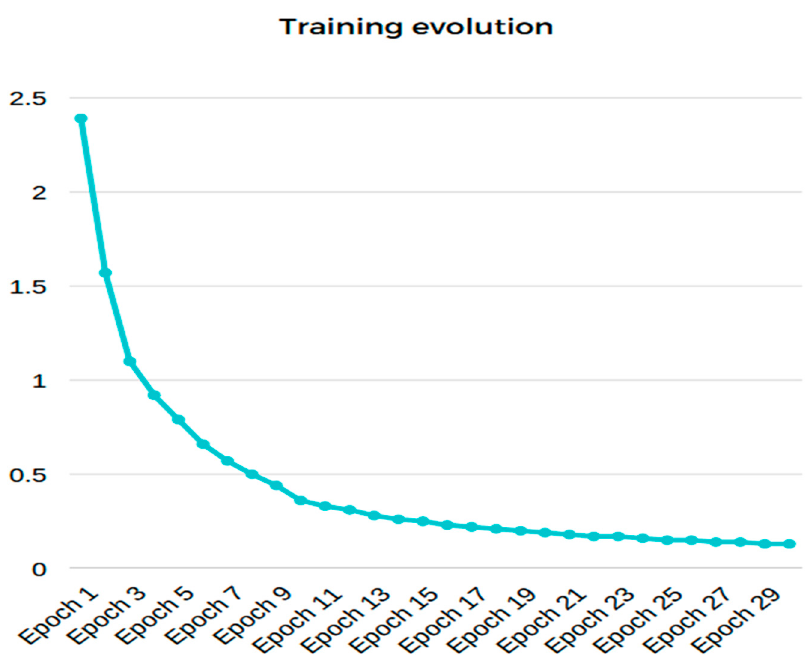
Figure 8. Training progress of the convolutional neural network. The X-axis describes the loss function value can be observed. The Y-axis shows the corresponding epoch.